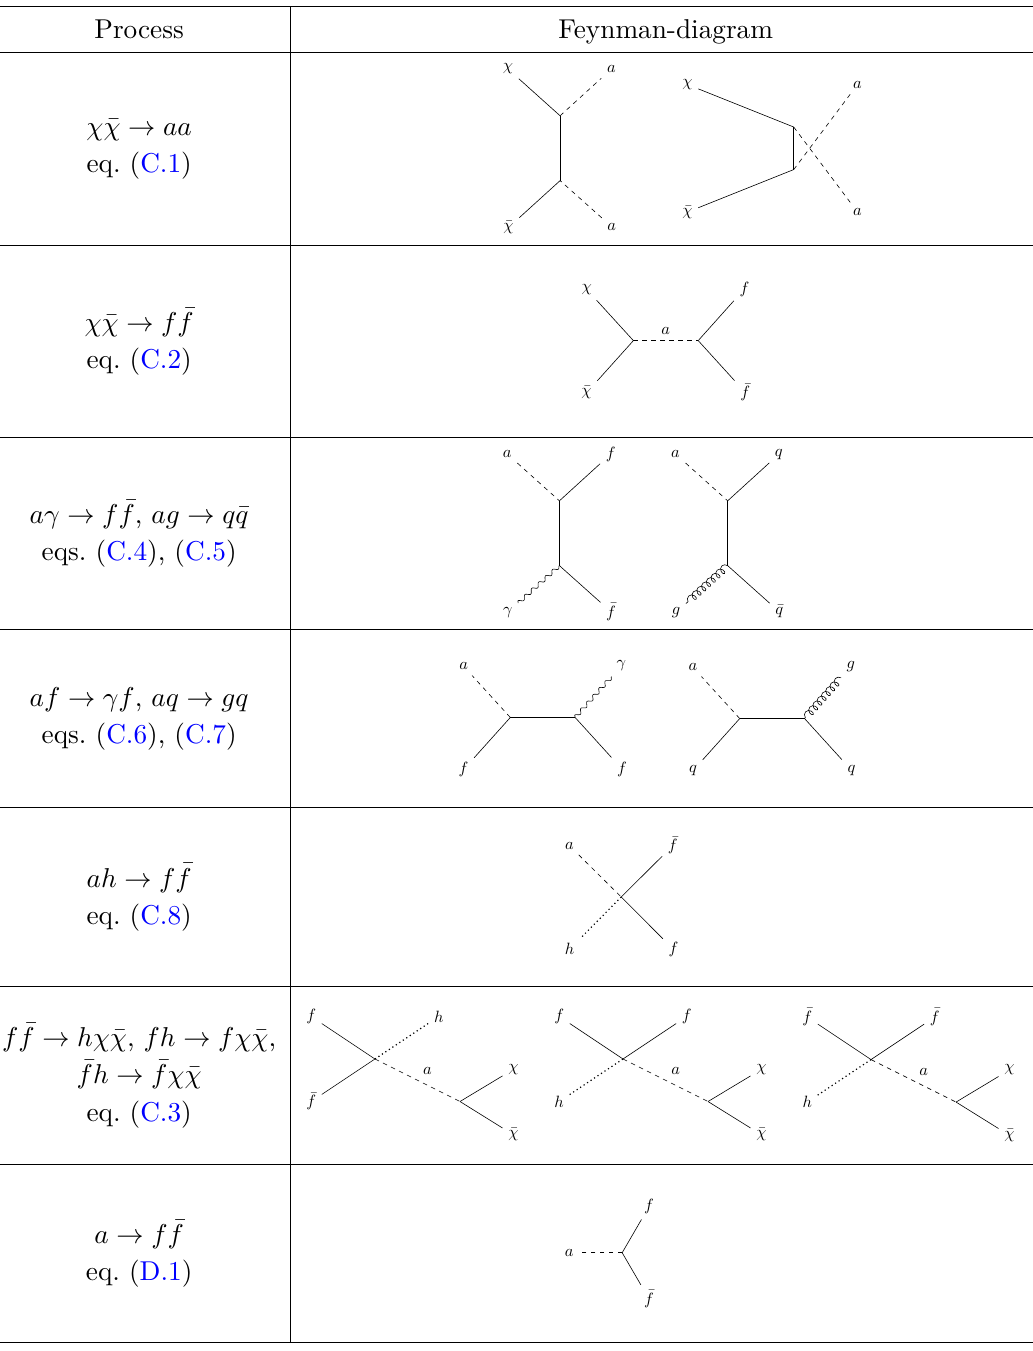
Table 2 . Feynman diagrams of the annihilation of the DM via the hidden sector and connector processes, as well as the co-annihilation of ALPs at tree